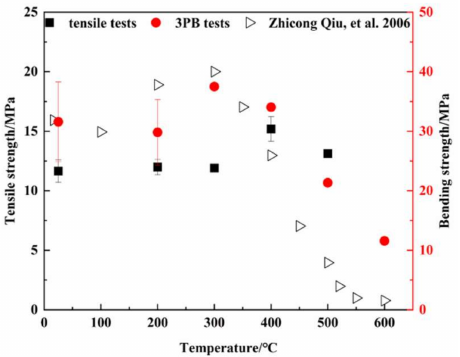
Figure 4. Temperature effect on strength of LiH obtained from tensile and 3PB